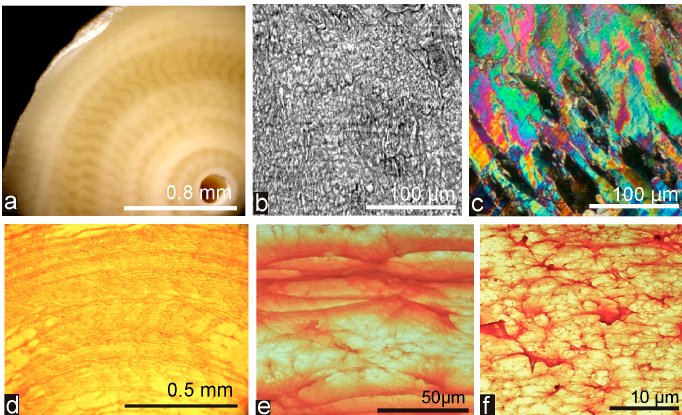
Figure 4. Microstructure, cristallinity and organic distribution in the Bamboo coral “Jasus” used in this study: ( a ) partial view of the specimens; ( b ) SEM view at medium enlargement: no clear indication of elongated and continuous fibers; ( c ) at the same enlargement, calcite is crystallized as small and rather disordered units; and ( d – f ) Acridine orange staining of the regular concentric growth layers ( d ).